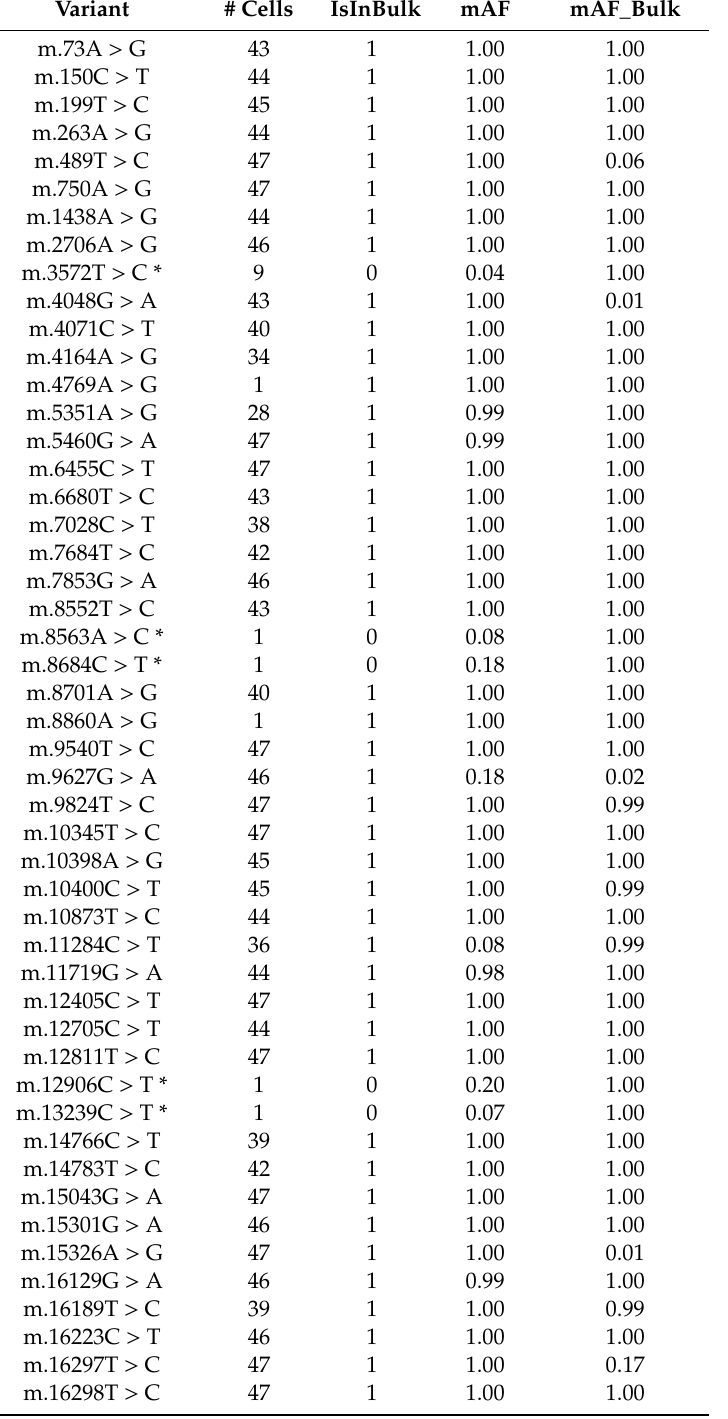
Table 3. Variants detected in 48 TF-1 cells sequenced using the ATACseq protocol according to the following thresholds: depth of 30 reads and minimum allele frequency of